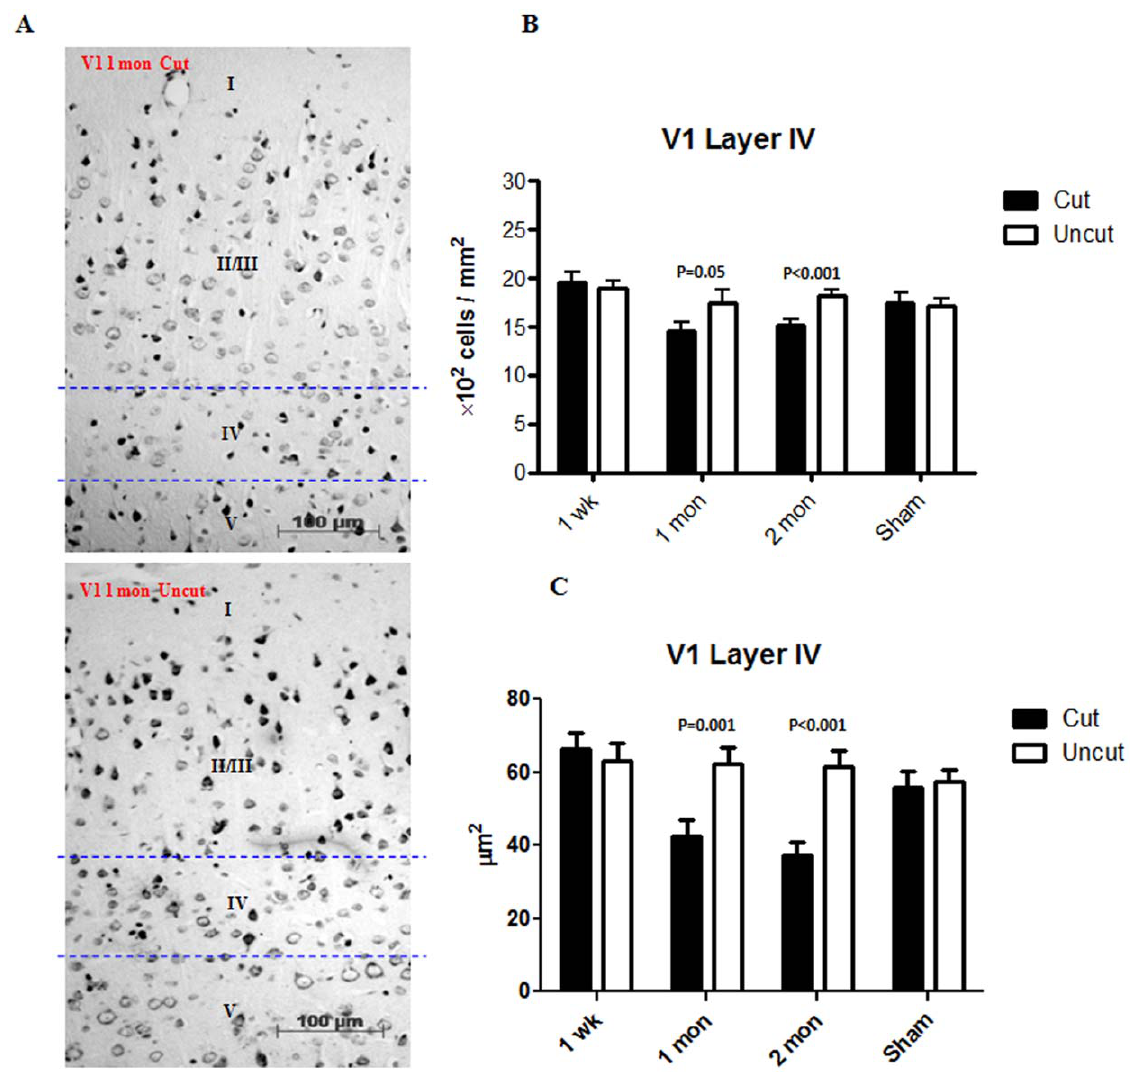
Figure 3. Histological changes in V1. (A) Representative sections (Nissl staining) of V1 from a rat sacrificed at month 1. (B) Changes in the cell density in layer IV of V1 from week 1 to month 2. (C) Changes in the cell size in layer IV of V1 from week 1 to month 2. (n=3 for each time point; n=2 for the sham control). Error bars represent SEM.